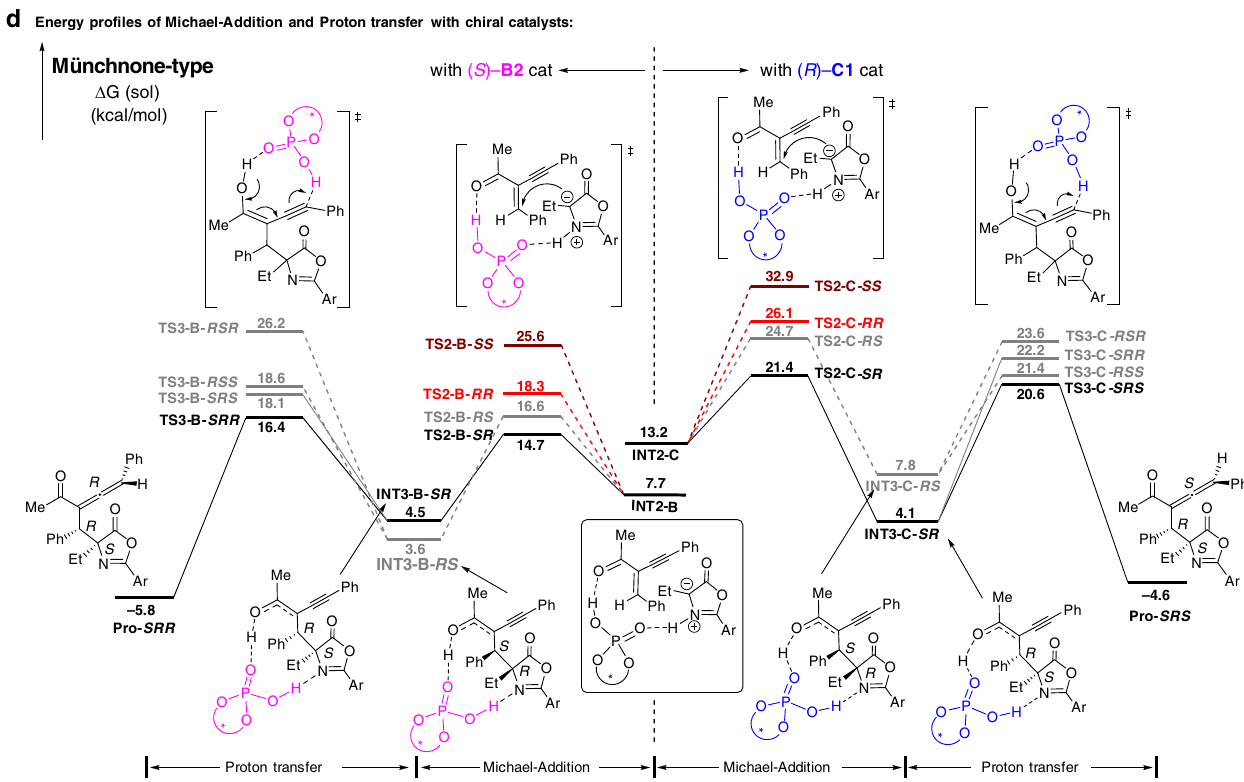
Fig. 4 Mechanistic studies. a Control experiments. b Initially proposed enol-type mode mechanism. c Comparison of the enol-type and Münchnone-type activation modes via calculation. d Energy pro fi les of Michael-Addition and proton transfer with CPA catalysts via DFT calculations. (The energy shown in kcal/mol, Ar =